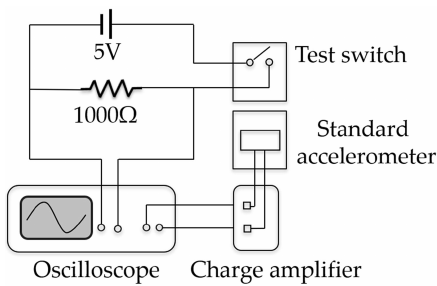
Figure 6. Schematic diagram of the test